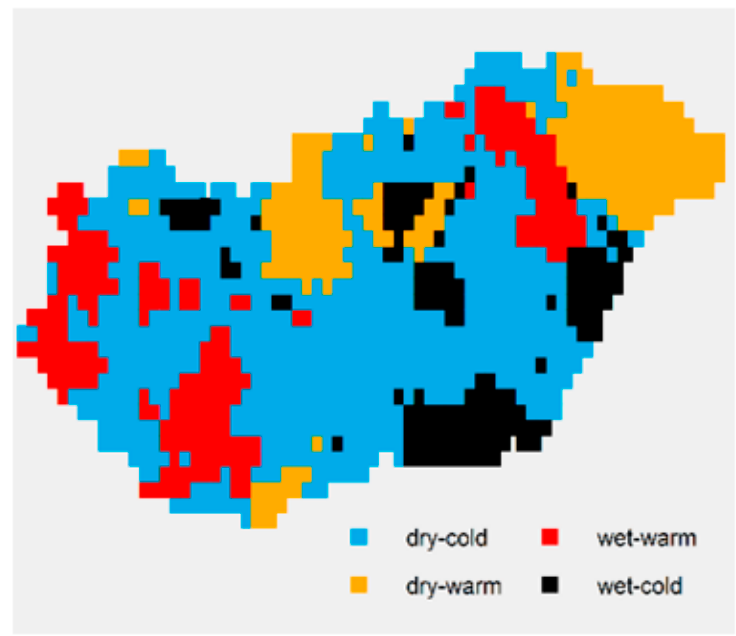
Figure 5. Characteristics of extreme months (January).